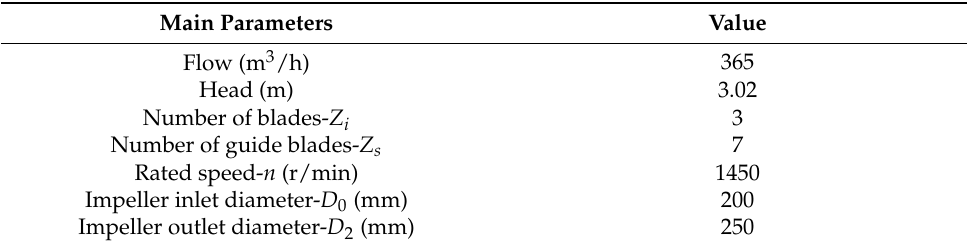
Table 1. Main geometric parameters of the model